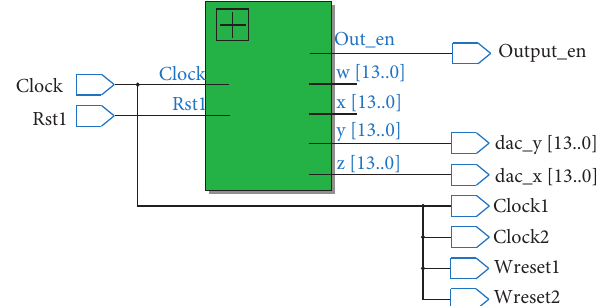
Figure 11: State machine flowchart.